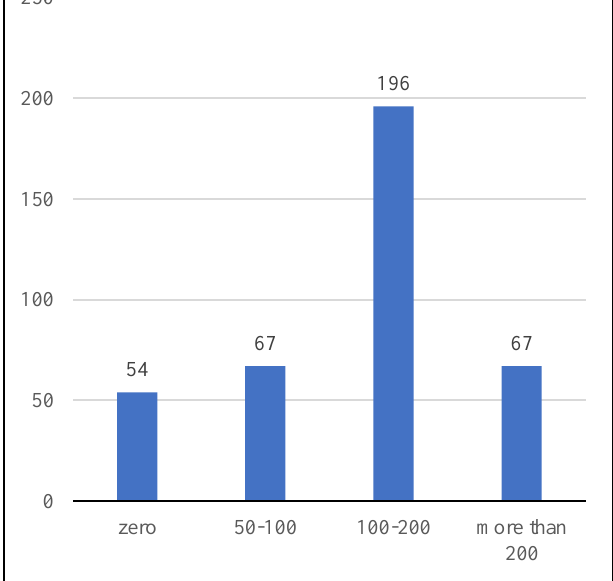
Fig. 10. Payment of waste management services